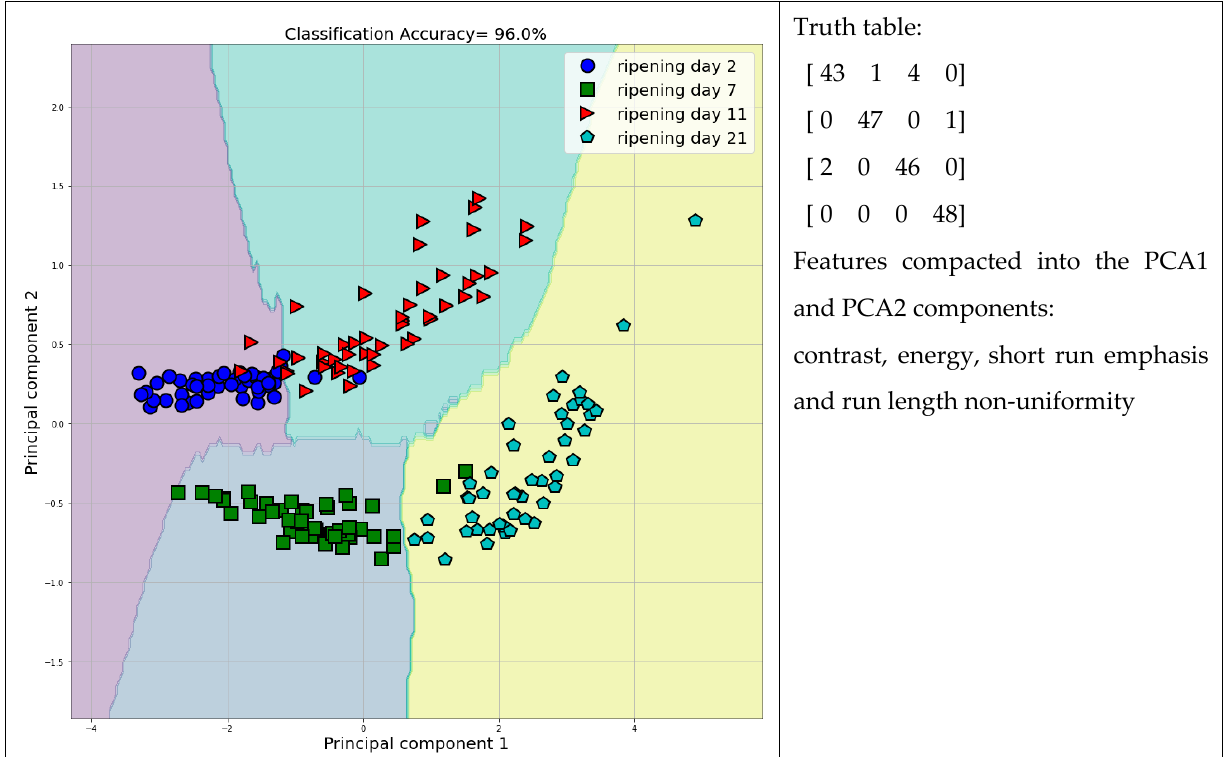
Figure 3. Scatter diagram of the discrimination, including textural features, amongst banana peel samples from days 2, 7, 11, and 21.